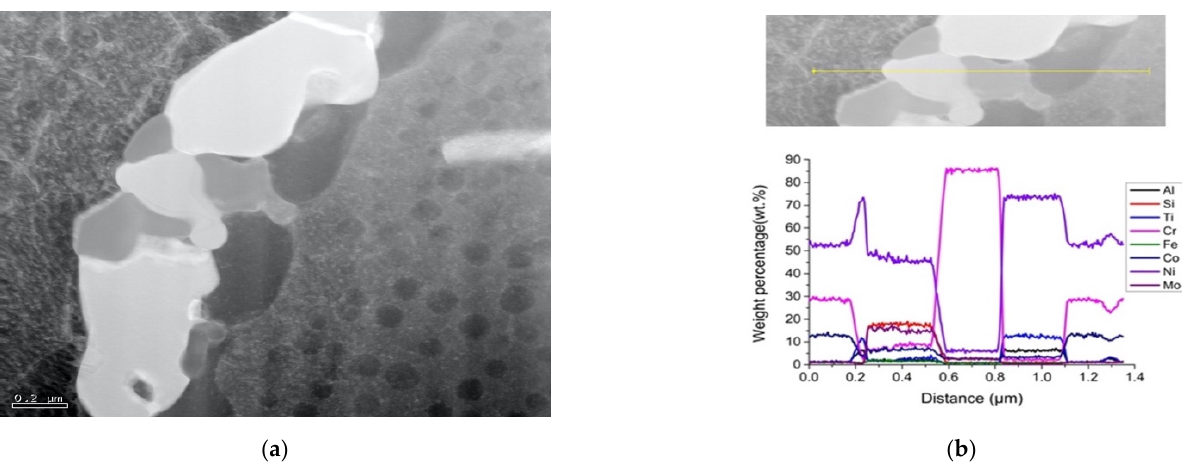
Figure 11. Grain boundary precipitates after SA: ( a ) TEM micrograph and ( b ) TEM-EDS line-scan cross the boundary.